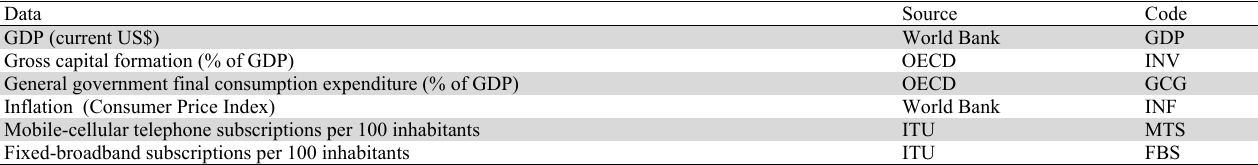
The sources of the